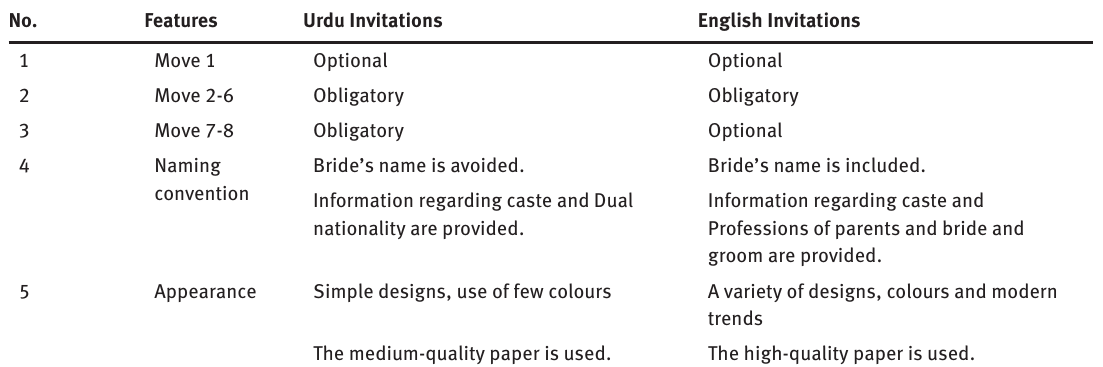
Table 2: A comparison of Urdu and English invitations